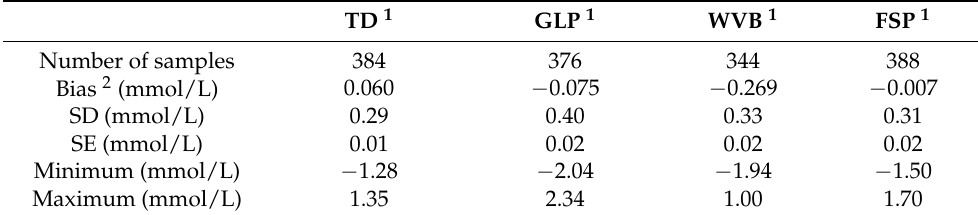
Table 3. Bias Bland–Altman Plot. Mean differences of β -hydroxybutyrate (BHBA) concentrations measured in whole blood and BHBA measured with the reference method in the laboratory. Blood samples were taken from 100 post-partum Holstein-Friesian dairy cows within 5 to 38 days after calving on four days (test days 2, 4, 9, 11) during the trial. TD 1 GLP 1 WVB 1